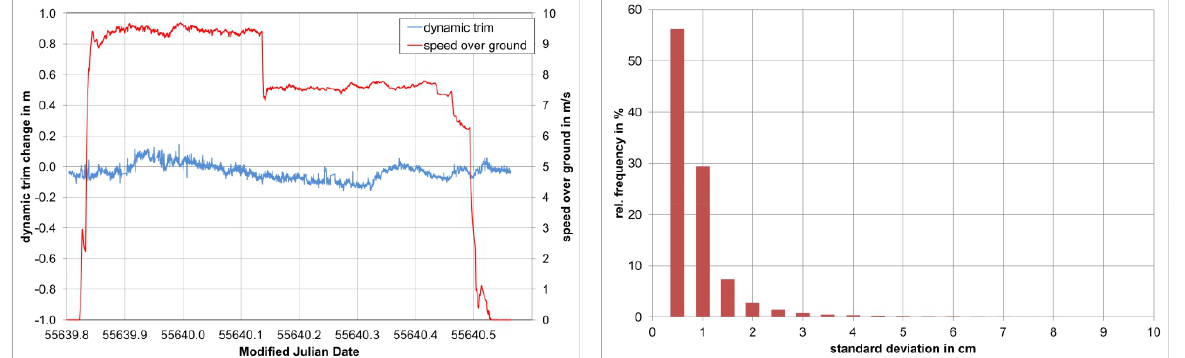
Figure 6. Dynamic trim change and speed over ground of the cruise vessel during the experiment.